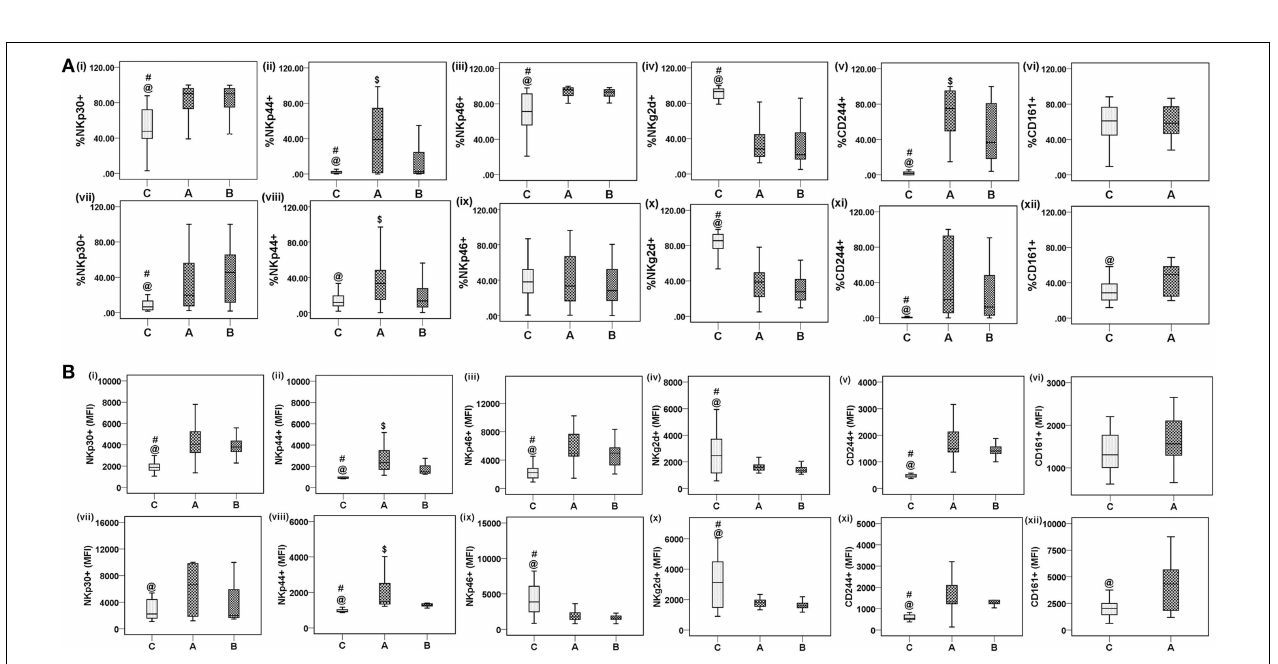
FIGURE 3 | Patterns of NK receptors (NKRs) on NK and NKT-like cells. Frequencies of NKRs were enumerated from the whole blood of 30 control subjects, 30 acute, and 31 convalescent patients. (A) Box plots (i-vi) show percentages of NKRs + NK (CD3 − CD56 + ) cells as (i) NKp30, (ii) NKp44, (iii) NKp46, (iv) NKG2D, (v) CD244, (vi) CD161. Box plots (vii–xii) shows FACS analysis of percentages of NKRs + NKT-like (CD3 + CD56 + ) cells as (vii) NKp30, (viii) NKp44, (ix) NKp46, (x) NKG2D, (xi) CD244, (xii) CD161. CD161 percentage was enumerated in acute patients and controls. (B) Box plots show mean fluorescence intensity (MFI) of NKRs + NK cells (i–vi) and NKRs + NKT-like cells (vii–xii). Kolmogorov–Smirnov test was used for intergroup comparison. p < 0 . 05 is considered significant.